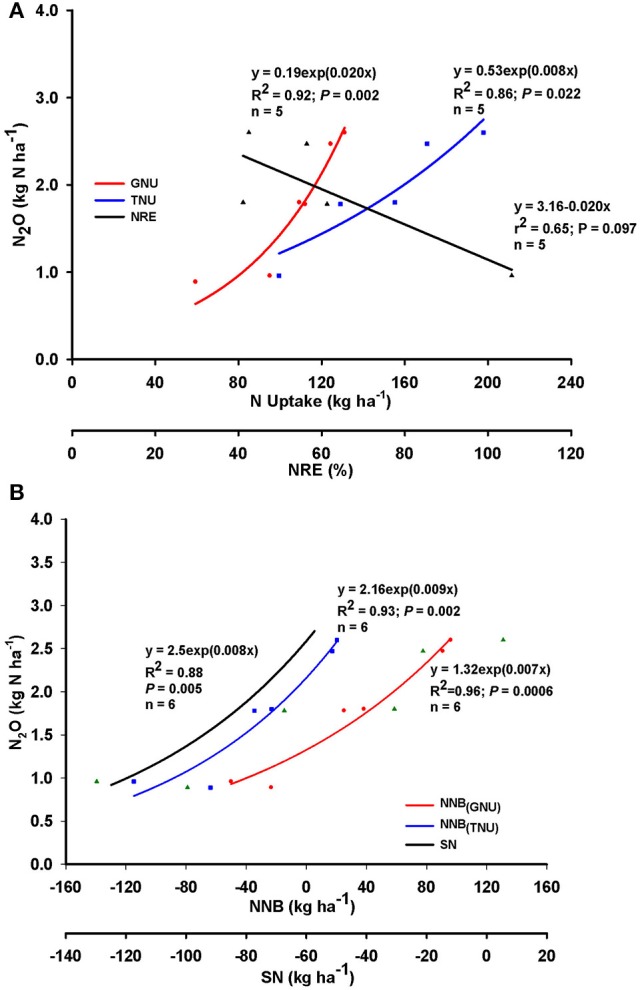
Relationship between nitrous oxide (N2O) emission and (A) grain N (GNU) and total N uptake (TNU) and N recovery efficiency (NRE), and (B) net N balance (NNB) relative to TNU, GNU and surplus N (SN) when management focused on N application rate and timing combination across Indiana and Minnesota (United States), and New Brunswick (Canada). n = number of N rate groups and points within each n group are mean values of 12, 4, 14, 8, 12, and 4 observations, respectively.